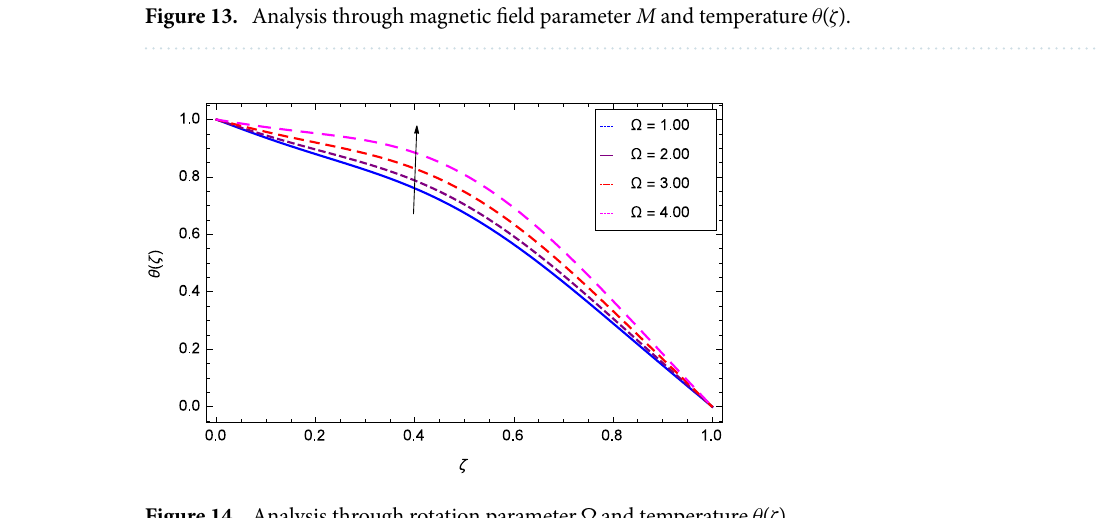
Figure 13. Analysis through magnetic field parameter M and temperature θ ( ζ ).